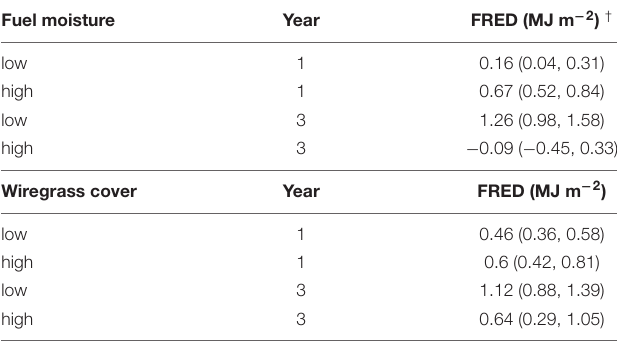
TABLE 7 | Effects of wiregrass cover and fuel moisture content by season of burn (Year 1 = dormant, Year 3 = growing) on FRED during experimental burns in longleaf pine forests in southwest Georgia, United States.